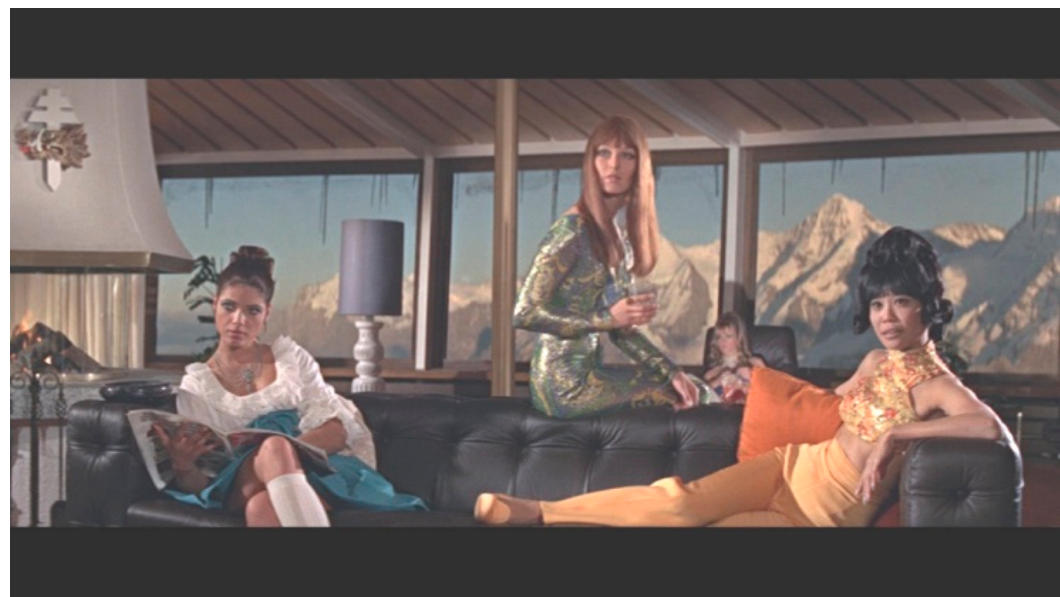
Figure 1. Blofeld’s biopolitical weapons ( On Her Majesty’s Secret Service ).